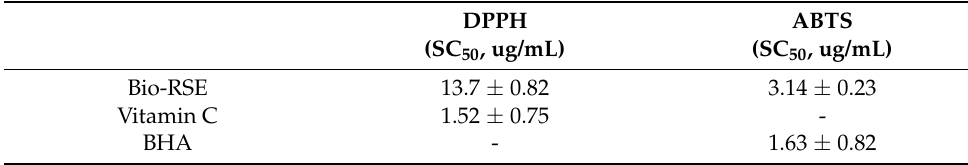
Table 2. DPPH and ABTS radical-scavenging activity of R. sachalinensis extract fermented with Bovista plumbea